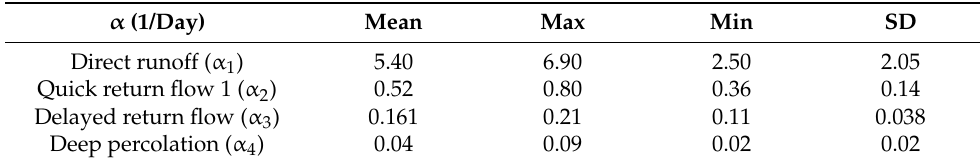
Table 3. Recession coefficient (1/day) descriptive statistics.